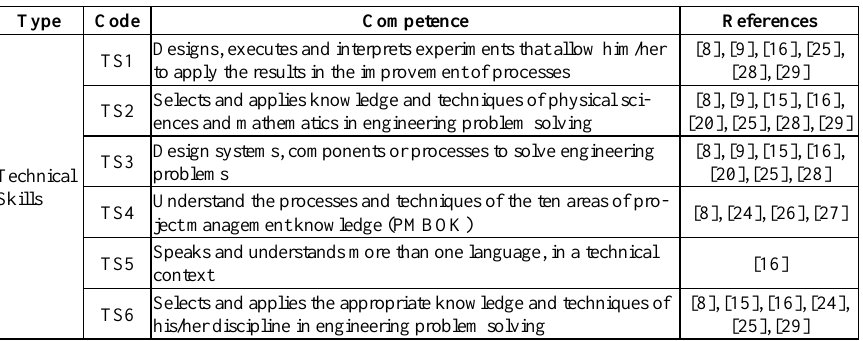
Table 2. Technical